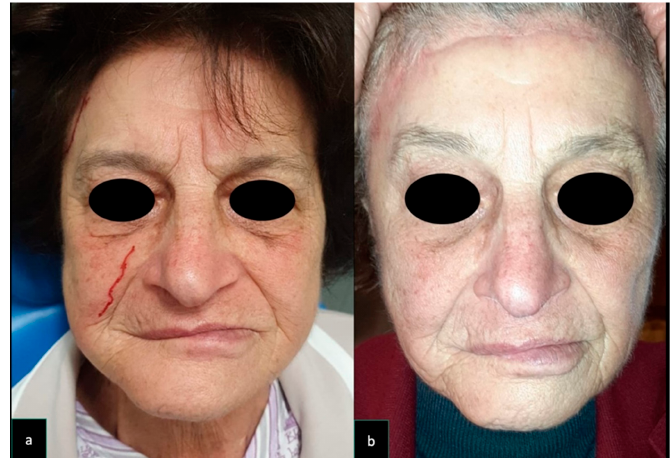
Figure 1. Case 6. A 79-year old woman underwent surgical excision for a recurrent left tuber maxillae squamous cell carcinoma. The patient had previously undergone a homolateral neck dissection